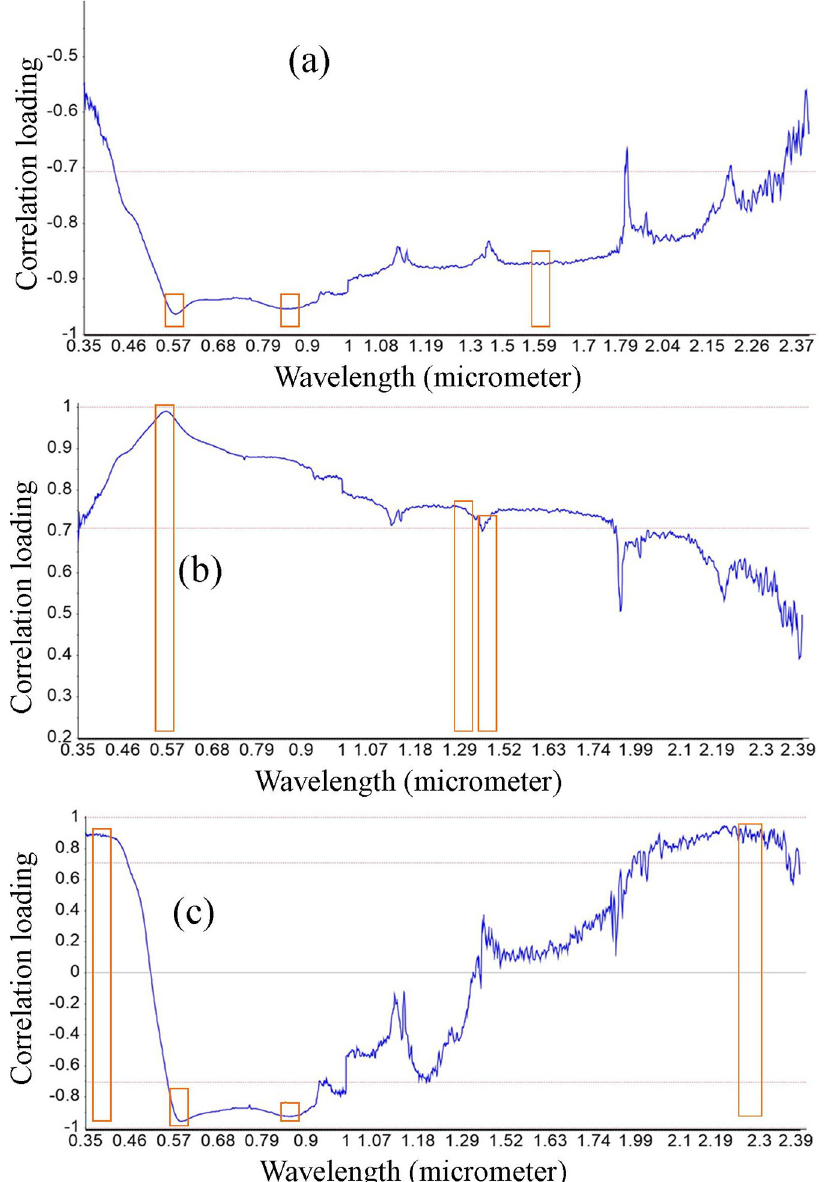
Fig 9. Loading (contribution) of relevant wavelength for modeling soil properties. (a) Clay, (b) Sand, and (c) organic carbon contents. For clay content, the best fit ( R 2 = 0.86, RMSE = 0.60) was: Clay ð % Þ ¼ 191 : 14 (cid:0) 809 : 96 � l 568 nm (cid:0) 674 : 25 � l 570 nm þ 2 : 15 � l 845 nm (cid:0) 70 : 94 � l 850 nm þ 1536 : 8 � l 1592 nm (cid:0) 1421 : 2 � l 1595 For sand, the best fit ( R 2 = 0.94, RMSE = 0.74) was: Sand ð % Þ ¼ (cid:0) 63 : 12 (cid:0) 628 : 9 � l 568 nm þ 1477 � l 570 nm þ 1105 : 7 � l 1290 nm (cid:0) 1479 : 5 � l 1295 nm þ 925 : 35 � l 1302 nm (cid:0) 572 : 87 l 1305 nm